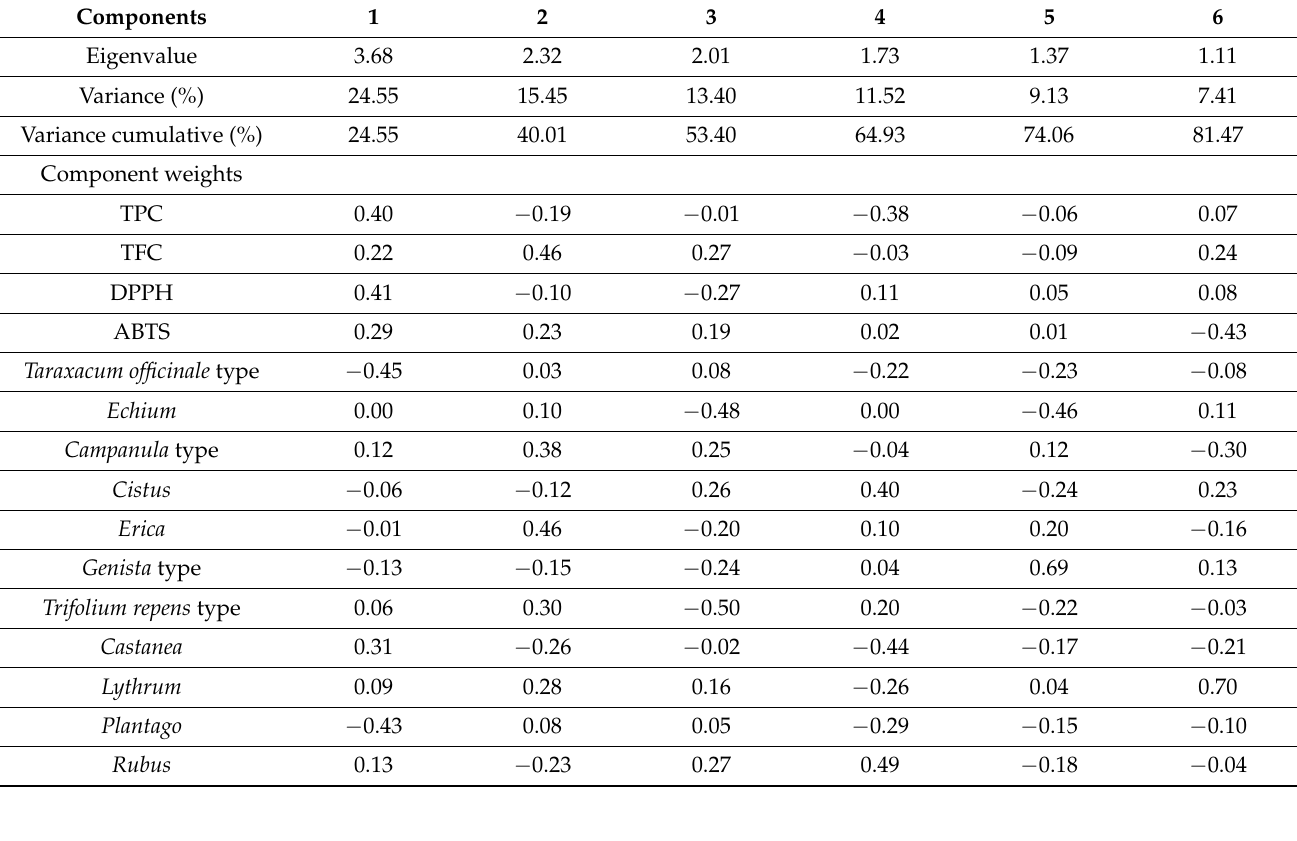
Table 3. Number of components extracted and component weights for each variable included in PCA.